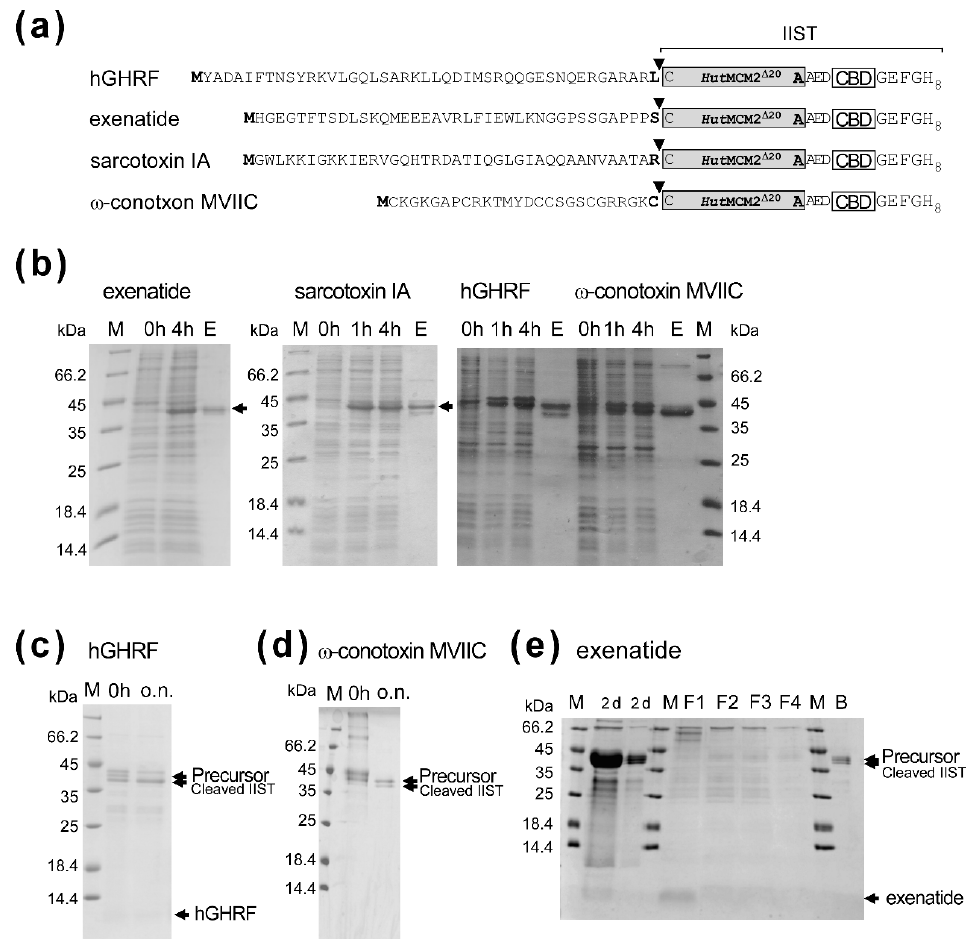
Figure 5. Applications of IIST to small peptides. ( a ) Schematic drawings of fusion constructs with various peptides. Inverse triangles indicate the cleavage sites. ( b ) SDS-PAGE analysis of protein expression and purification with exenatide, sarcotoxin IA, hGHRF, and ω -conotoxin MVIIC. M stands for molecular weight markers. 0 h, 1 h, 4 h, and E stand for samples at 0 h, 1 h, 4 h after protein expression, and elution from IMAC, respectively. Unlabeled arrows indicate bands for fused precursor proteins below the 45-kDa marker. ( c ) Salt-cleavage of hGHRF-IIST. The purified hGHRF-IIST (precursor) by IMAC was incubated in the salt solution (50 mM DTT, 2 M NaCl) overnight (ca. 18 h). ( d ) Salt-cleavage of ω -conotoxin MVIIC-IIST. The purified ω -conotoxin MVIIC-IIST (precursor) was cleaved in the salt solution (10 mM DTT, 0.5 M sodium phosphate, 0.5 M NaCl). 0 h and “o.n.” indicate the samples before incubation and after 20-h incubation, respectively. ( e ) Tricine-SDS-PAGE analysis of the purification and cleavage of the tagged exenatide. M stands for molecular weight markers. “2 d” indicates samples after a 2-day cleavage reaction. F1, F2, F3, and F4 indicate the flow-through fractions from the chitin-beads column. B stands for the bound fraction to chitin beads. 20% Tricine-SDS-PAGE was used to visualize exenatide